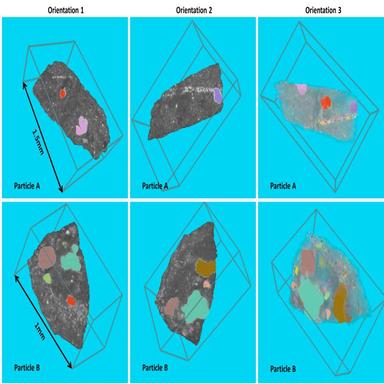
3D volume renderings of 2 selected particles. For orientation 1&2, colored areas (gray color excluded) show exposed surface of Cu mineral grains. For orientation 3, colored clusters show individual Cu mineral grains with other minerals set half transparent.